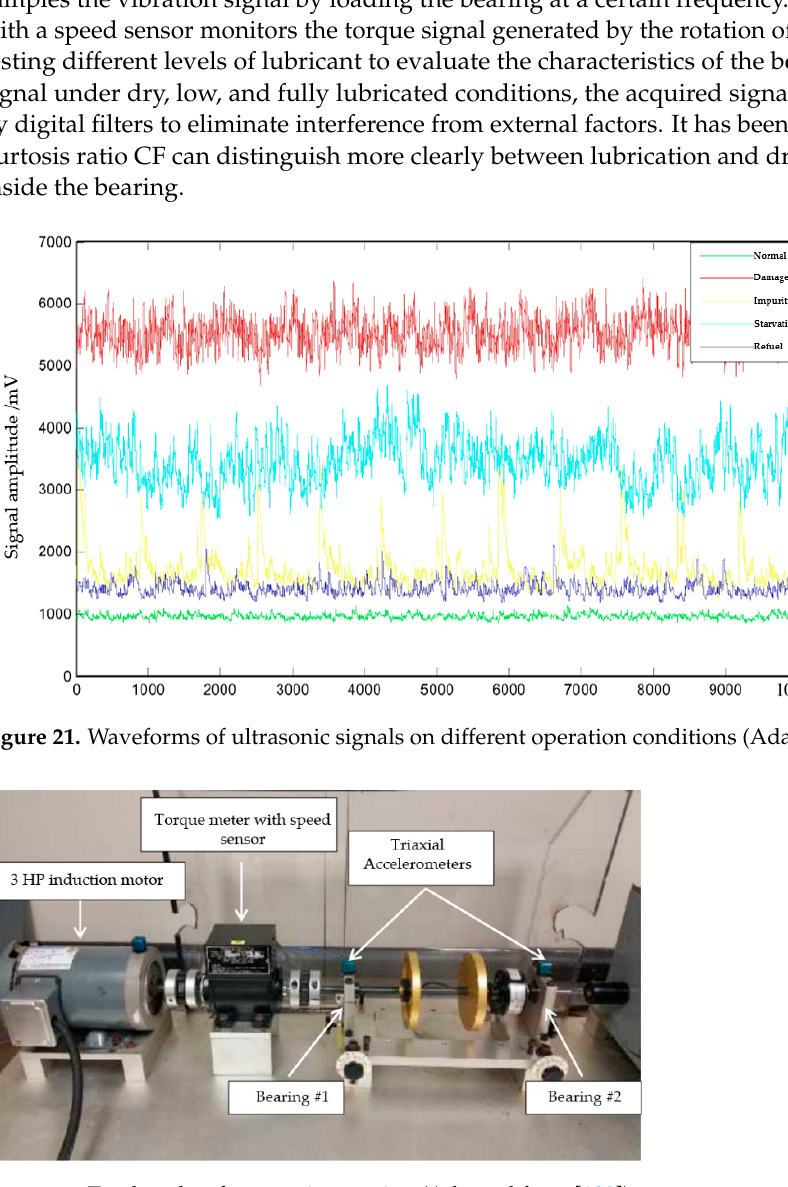
Figure 22. Test benches for experimentation (Adapted from[189]).